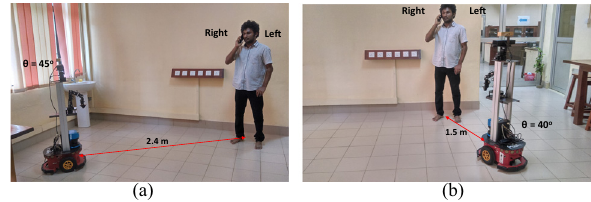
Figure 8: Two occasions encountered during PHN in Table 2. ( a ) Positions of the robot and the user initially as the robot observes the user. ( b ) Positions of the robot and user after approaching the user. The orientation and the interpersonal distances during these two occasions are